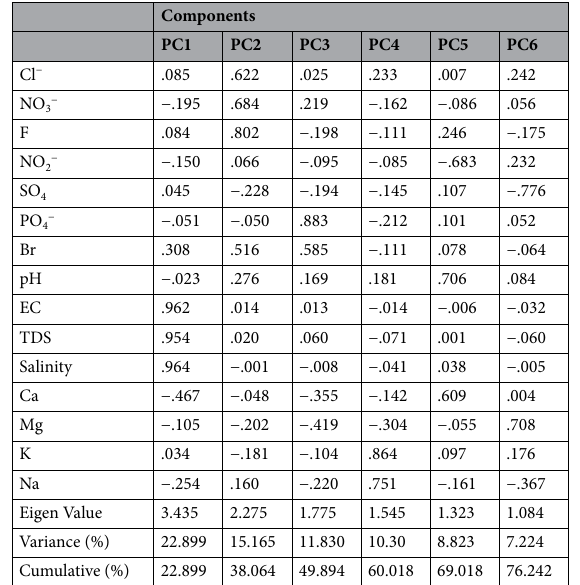
Table 4. Principle component analysis. Rotated component matrix (Varimax rotation). Extraction method: Principal Component Analysis. Rotation Method: Varimax with Kaiser